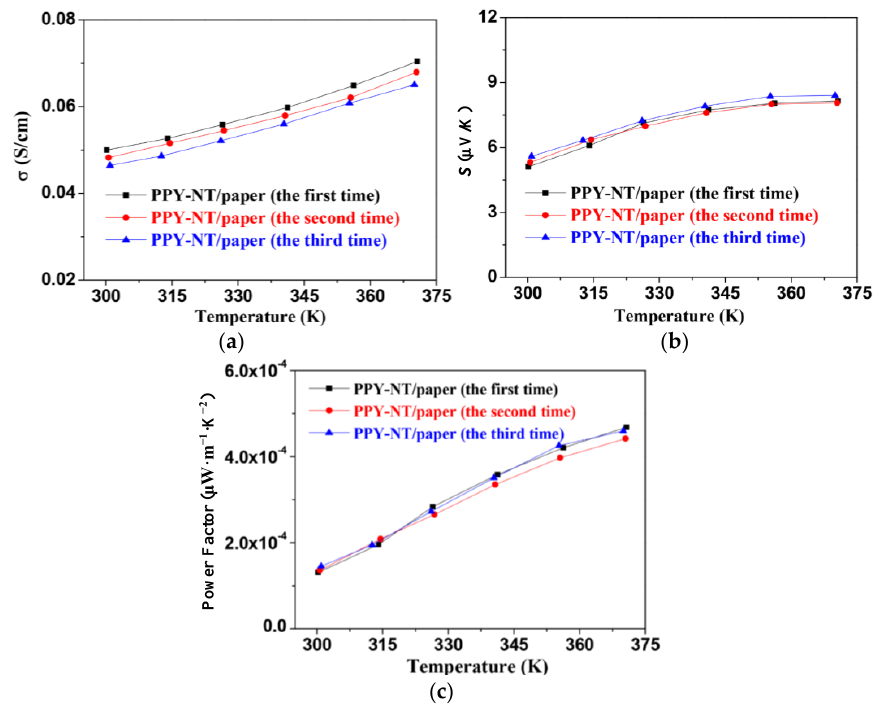
Figure 5. ( a ) Electrical conductivity, ( b ) Seebeck coefficient, and ( c ) calculated power factor of the PPy–NT/paper composite film.